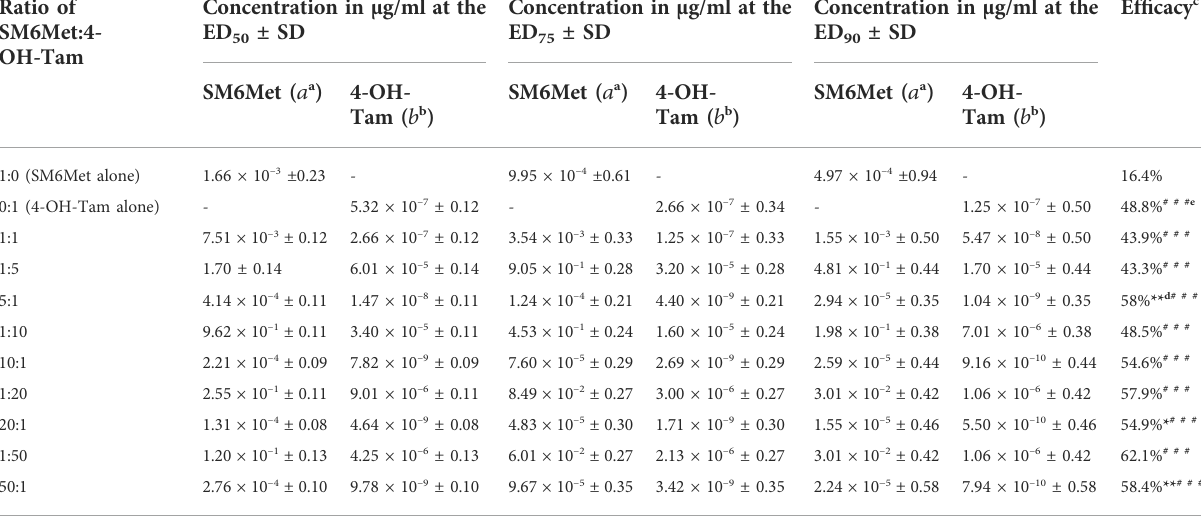
a Variable representing the concentration of SM6Met used in the speci fi ed combination ratio that elicits the 50%, 75% or 90% inhibitory effect calculated from the dose response curve depicted in Figures 2A,B. b Variable representing the concentration of 4-OH-Tam used in the speci fi ed combination ratio that elicits the half maximal 50%, 75% or 90% inhibitory effect calculated from the dose response curve depicted in Figures 2A,B. c Ef fi cacy shown as % inhibition of E 2 -induced proliferation. d Statistically different from 4-OH-Tam alone — 0:1 (* represents p < 0.05, ** represents p < 0.01 and *** represents p < 0.001). e Statistically different from SM6Met alone i.e., 1:0 ( # represents p < 0.05, # # represents p < 0.01 and # # # represents p <